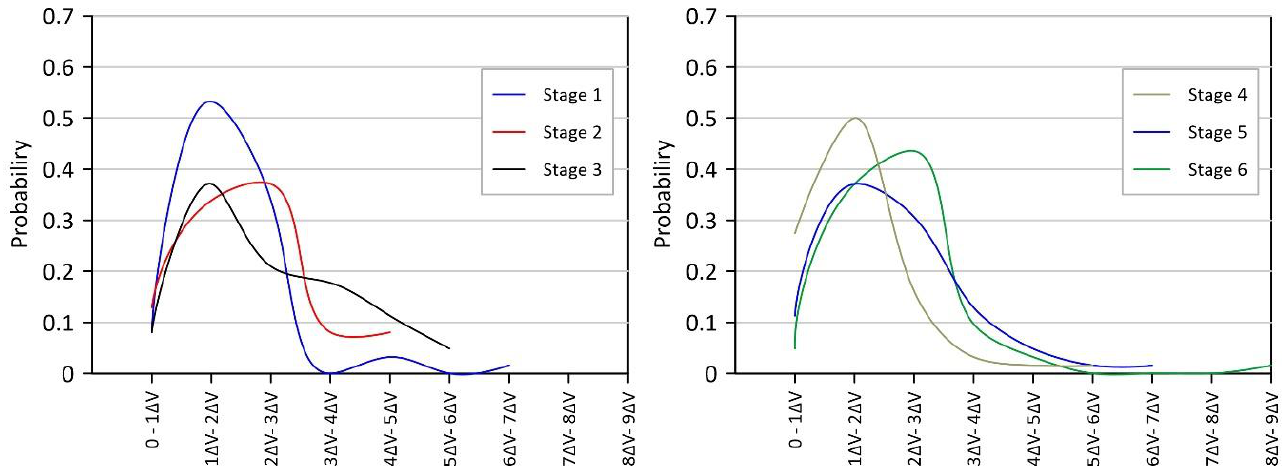
Figure 5. Probability values for Malpaso dam.